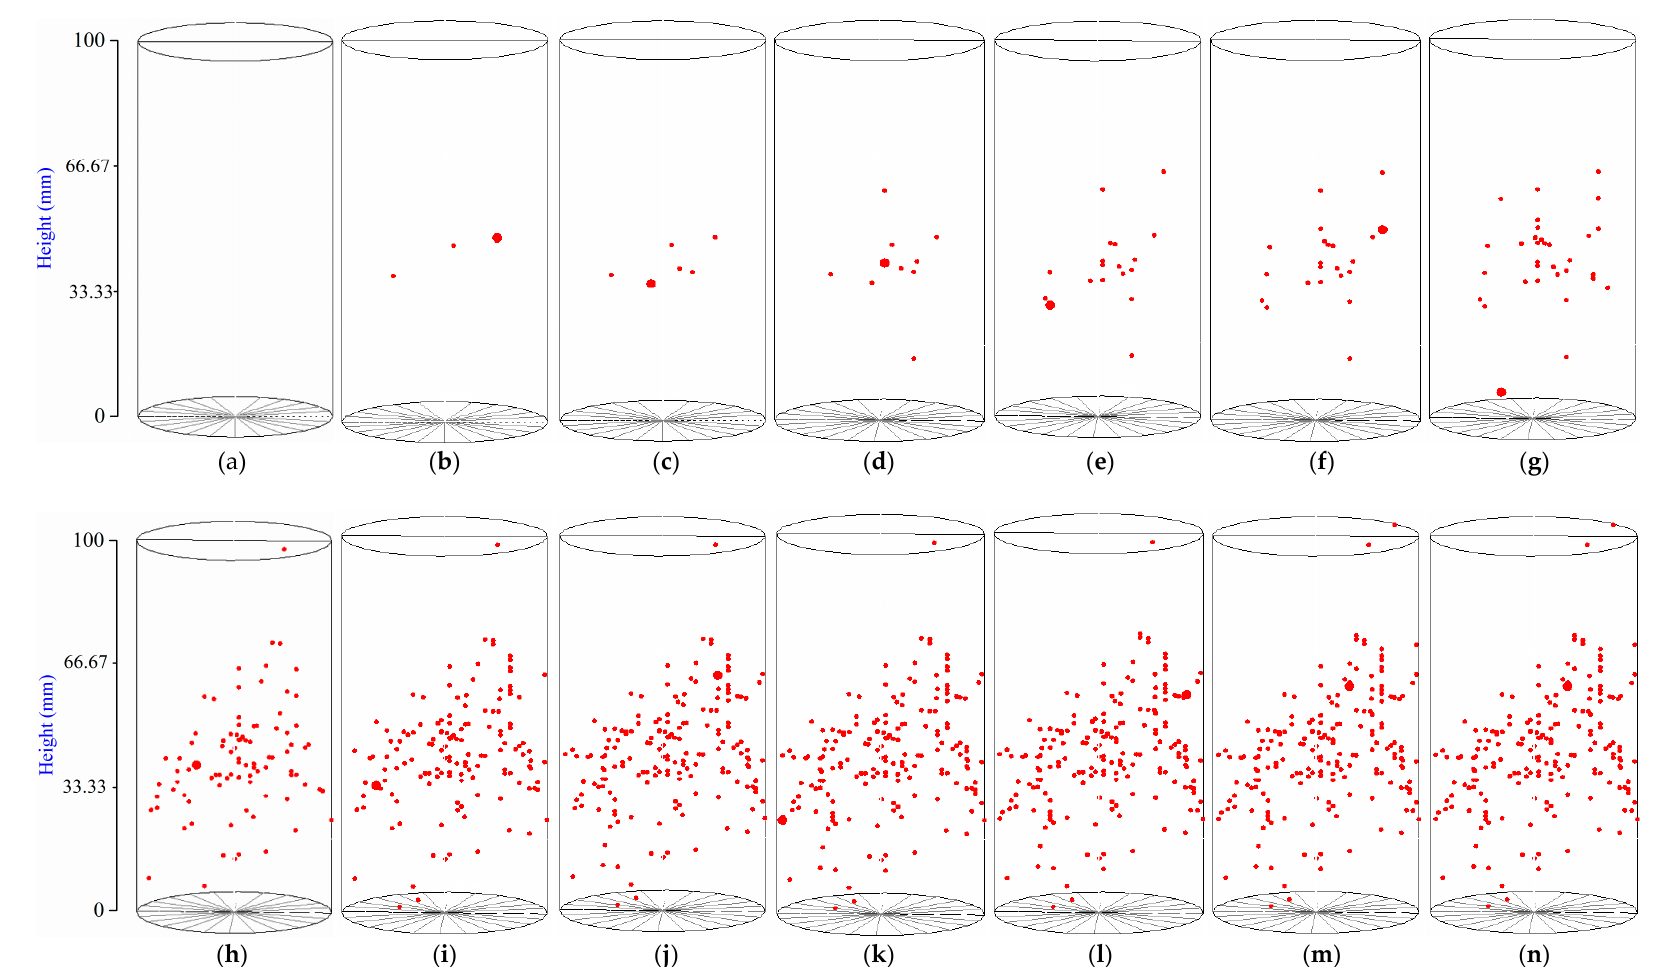
Figure 9. Distribution of AE events of the R-C-R sandwiched coal-rock specimen during the loading process. The letters shown in the figure correspond to the purple markers of Figure7(c). ( a ) 0 s;( b ) 100 s;( c ) 200 s;( d ) 250 s; ( e ) 300 s;( f ) 350 s; ( g ) 400 s; ( h ) 450 s; ( i ) 500 s; ( j ) 525 s; ( k ) 600 s; ( l ) 700 s; ( m ) 800 s; ( n ) 904 s.